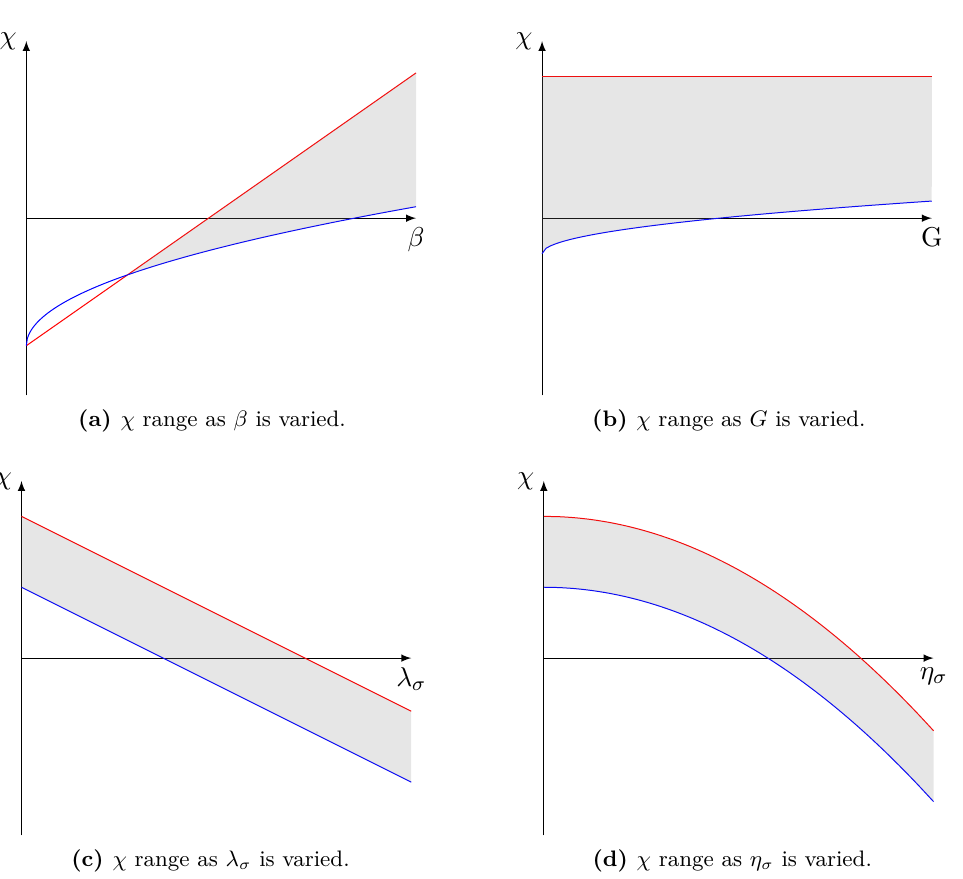
Figure 3 . Plots showing (qualitatively) how the range of χ for which superconducting strings can form changes with each parameter while the others are kept fixed. The red and blue lines respectively show the dependency of χ and χ on each parameter and the shaded area shows max min the region of the parameter space in which superconducting strings can form. Note that we have not attempted to include the behaviour of χ when the vacuum is a local minima of the potential max as we do not know the exact dependence of the new upper limit on each parameter. The upper plots demonstrate that the width of the χ range changes with β and (to a lesser extent) G , while it is clear from the lower two plots that λ and η only shift the range — linearly for the former σ σ and quadratically for the